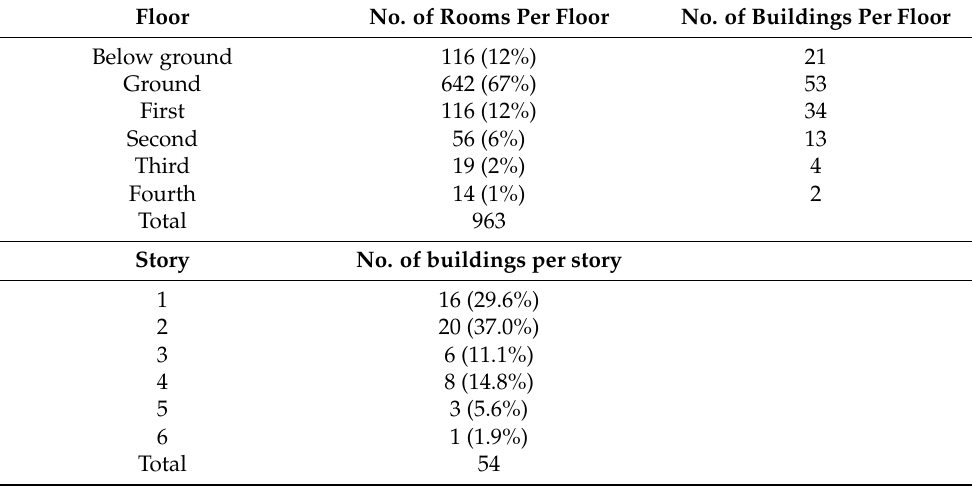
Table 1. Description of measured rooms and buildings per floor level (top) and of measured buildings per story level (bottom).